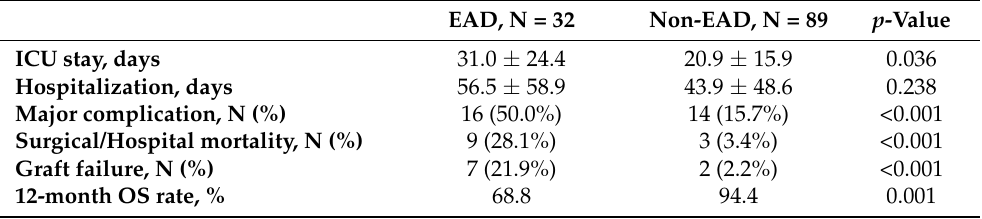
Table 2. Post-operative outcomes of the patients after LDLT according to development of EAD or